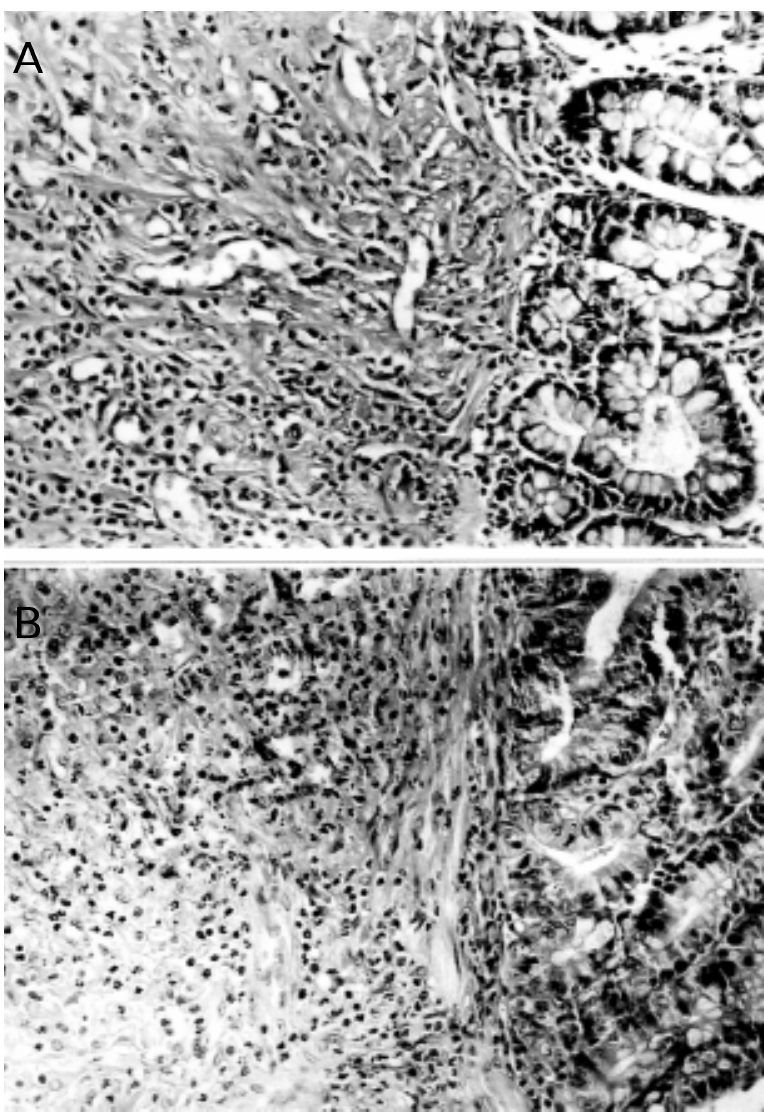
Figure 1 - Jejunal anastomosis of the control group (A) and animals submitted to sodium carboxymethylcellulose and a corticoid (B) on the 21st day after surgery. A , Observe the scarce peritoneal fibrinous tissue, relatively well constituted, with numerous thick collagen fibers, few inflammatory cells, and little vascular formation. B , Note the extensive although immature fibrous tissue with rare thick collagen fibers. Hematoxylin and eosin. A and B, Magnification =